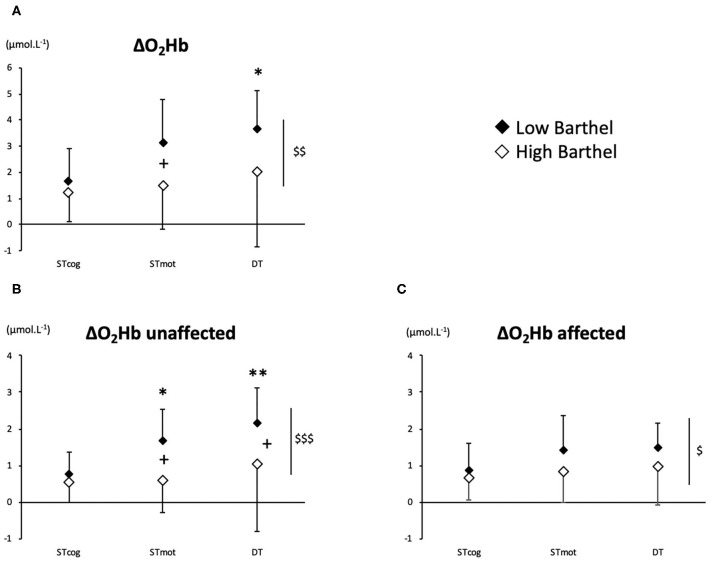
PFC oxygenation values (A: ΔO2Hb; B: ΔO2Hb-unaffected; C: ΔO2Hb-affected) for LoB (black dots) and HiB (white dots) patients in three tests: STcog, STmot, and DT (mean ± SD). LoB patients: condition vs. STcog (*P < 0.05, **P < 0.01); LoB vs. HiB (overall), +P < 0.05; LoB vs. HiB, $P < 0.05, $$P < 0.01, $$$P < 0.001.